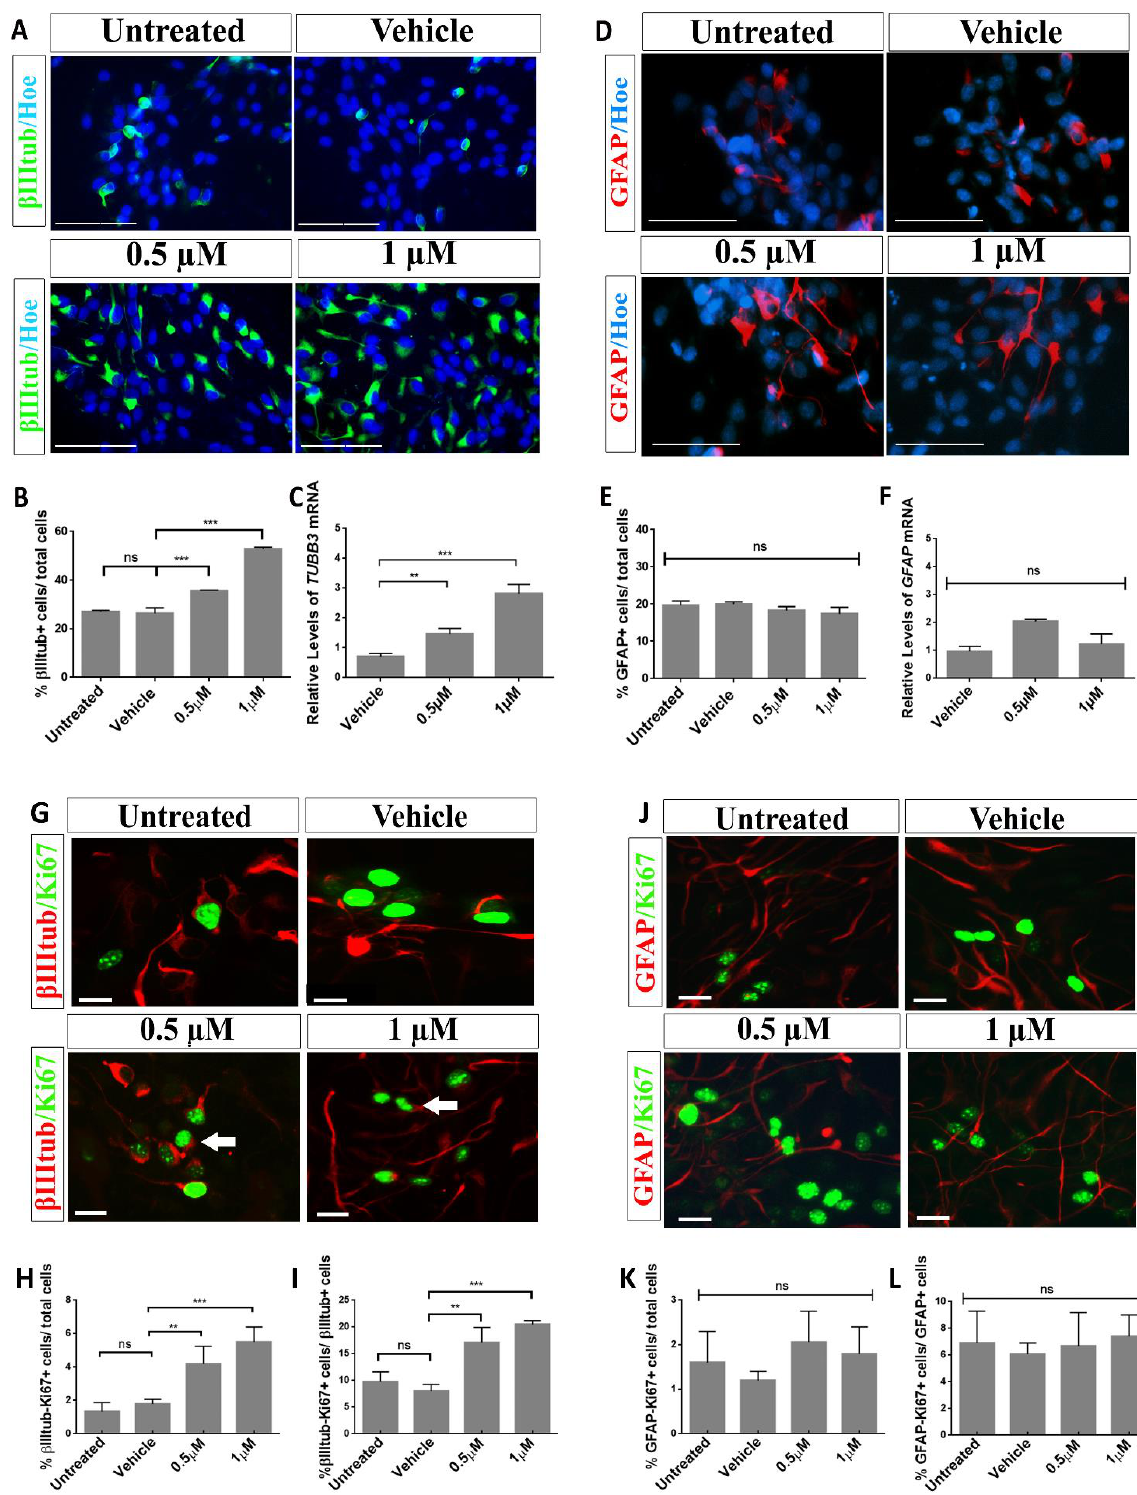
Figure 2. A β 40 treatment stimulates neurogenesis in differentiated hNS1 cells. ( A ) Representative images showing β -III-tubulin immunoreactivity ( β IIItub; green). ( B ) Percentage of β -III-tubulin+ cells/total cells after treatment with the A β 40 peptide. ( C ) Relative expression levels of TUBB3 mRNA by RT-qPCR analysis. ( D ) Images of GFAP immunoreactivity (red). ( E ) Percentage of GFAP+ cells/total cells after treatment with the A β 40 peptide. ( F ) Relative expression levels of GFAP mRNA obtained by RT-qPCR analysis. Cell nuclei in ( A , D ) were stained with Hoechst